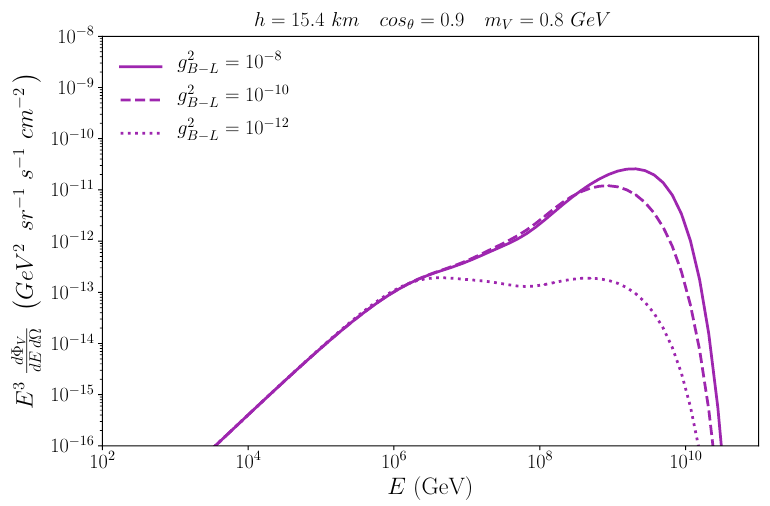
Figure 11 . V (cid:13)uxes in the B (cid:0) L model with m V = 0 : 8 GeV and for three values of g 2